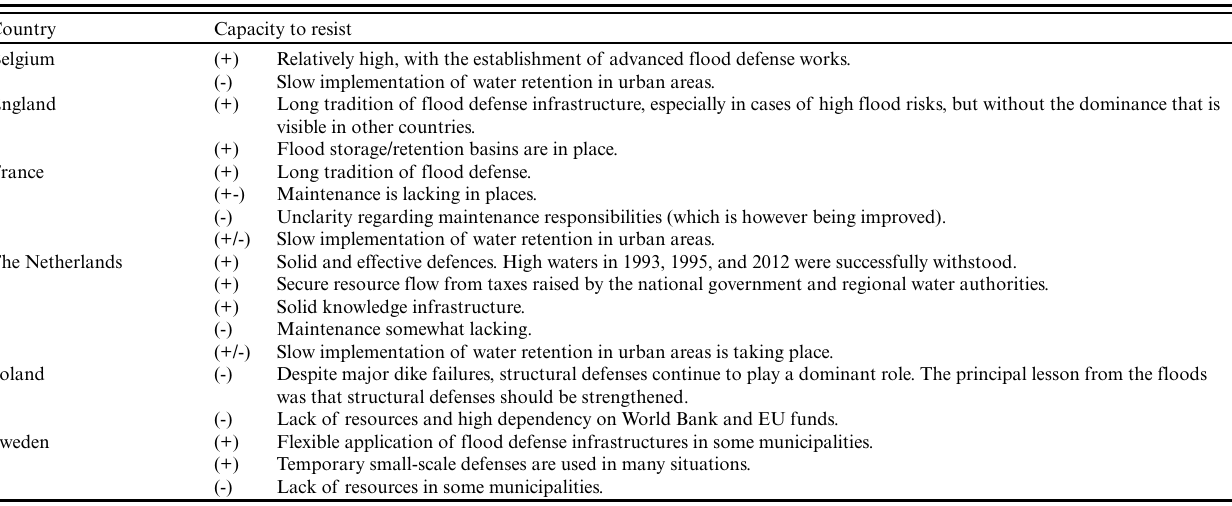
Table 4 . Capacity to resist in the six evaluated countries.